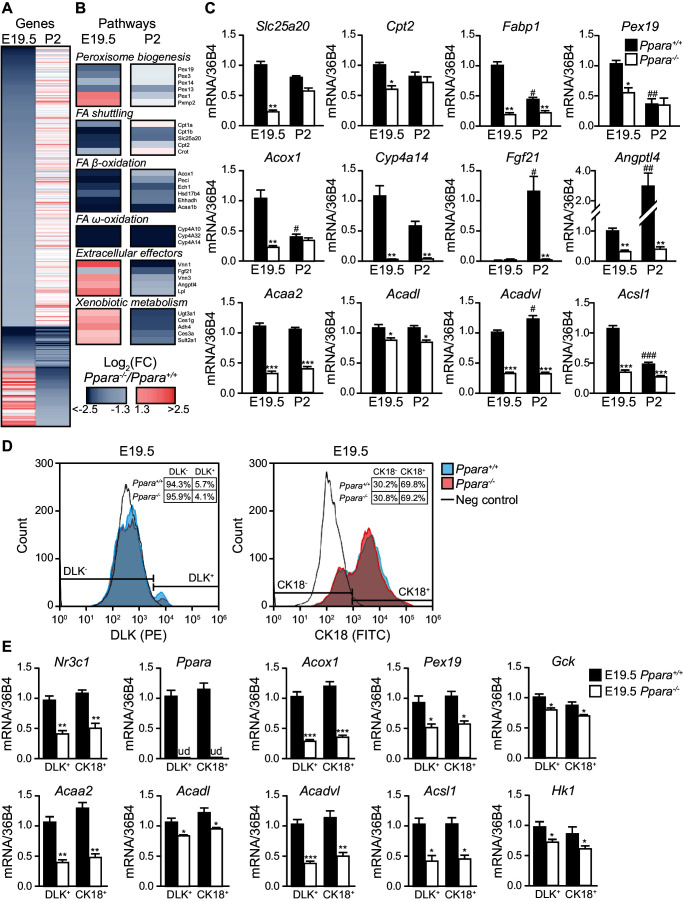
PPARα is a functional transcription factor in the term fetus.(A) Heat map of genes significantly altered at E19.5 (left panel) or P2 (right panel) in Ppara-/- livers (red: up-regulation; blue: down-regulation). Genes were grouped by fetal (E19.5) or postnatal (P2) expression and ordered by strength of regulation based on the logarithmic fold change (log2FC). (B) Gene ontology summarizing prenatal and postnatal PPARα-mediated regulation of metabolic pathways. (C) mRNA levels of representative PPARα target genes with differential fetal (E19.5) and postnatal (P2) regulation in Ppara-/- and Ppara+/+ livers. Slc25a20: carnitine translocase; Cpt2: carnitine palmitoyltransferase 2; Fabp1: fatty acid binding protein 1; Pex19: peroxisome biogenesis factor 19; Acox1: peroxisomal acyl-CoA oxidase 1; Cyp4a14: cytochrome P450 4A14; Fgf21: fibroblast growth factor 21; Angptl4: angiopoietin-like protein 4; Acaa2: acetyl-CoA acyltransferase 2; Acadl: acyl-CoA dehydrogenase, long chain; Acadvl: acyl-CoA dehydrogenase, very long chain; Acsl1: acyl-CoA synthetase, long-chain family member 1. Data are presented as mean ± SEM; n = 6, *p<0.05, **p<0.01, ***p<0.001 vs. wild-type controls; #p<0.05, ##p<0.01, ###p<0.001 vs. respective E19.5 samples. (D) Flow cytometric analyses of hepatoblasts (DLK+) and hepatocytes (CK18+) in fetal livers at E19.5. (E) mRNA expression levels of Nr3c1, Ppara, and PPARα target genes involved in peroxisome biogenesis (Pex19), peroxisomal and mitochondrial FAO (Acox1, Acaa2, Acadl, Acadvl, and Acsl1) in sorted fetal hepatoblast and hepatocyte fractions. Glycolytic genes (e.g., Gck and Hk1) were also investigated in parallel with oxidative genes. Nr3c1: glucocorticoid receptor; Ppara: peroxisome proliferator-activated receptor α; ud: undetermined; Gck: glucokinase; Hk1: hexokinase 1. Data are presented as mean ± SEM; n = 4, *p <0.05, **p<0.01, ***p<0.001 vs. wild-type controls.DOI:
http://dx.doi.org/10.7554/eLife.11853.00410.7554/eLife.11853.005Figure 2—source data 1.A list of PPARα-regulated genes and pathways in prenatal and neonatal livers.The dataset provides a list of PPARα-regulated genes (A) and pathways (B) in E19.5 and P2 mouse livers. Significant genes based on a false discovery rate < 0.05 were classified as regulated at both E19.5 and P2, in E19.5 only, or P2 only. The logarithmic fold change (logFC) cut-off value was set at 1.3. For each group, the significant enrichment of underlying KEGG, GO, and Reactome curated pathways was determined from the hypergeometric distribution and corrected for multiple comparisons.